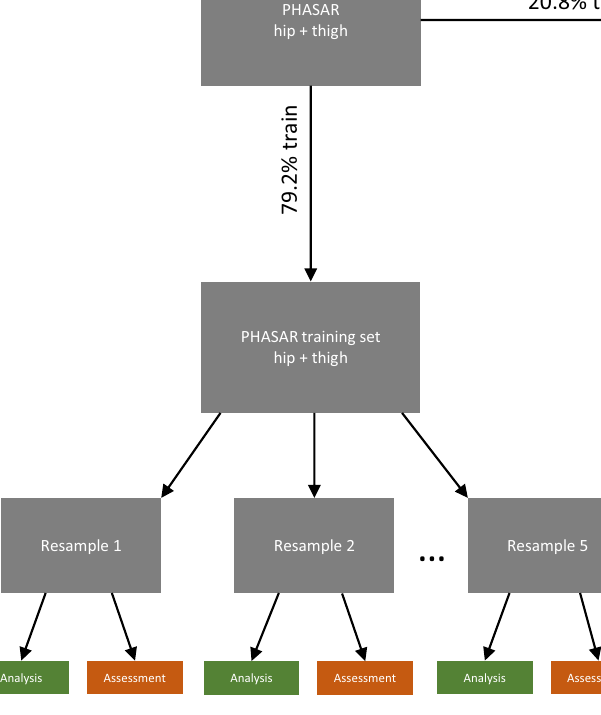
Figure 1. Flowchart of the splitting of the PHASAR dataset into train and test. The boxes on the left represent 79.2% of the PHASAR data for training in the five-fold resamples. The yellow and blue boxes on the right represent 20.2% of the PHASAR data for testing being split up into hip and thigh data while the green box is our in-house test dataset collected from wrist-worn